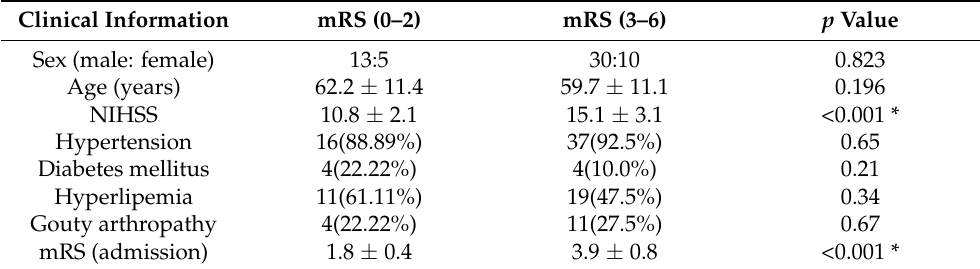
with mRS (3–6). Values are mean ± standard deviations.